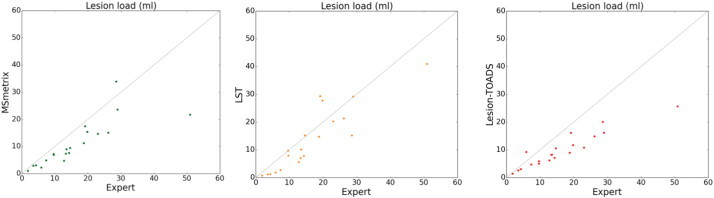
Scatter plots of expert reference values versus automatically computed values for total lesion volume (ml). The three columns show results for MSmetrix, LST and Lesion-TOADS, respectively.